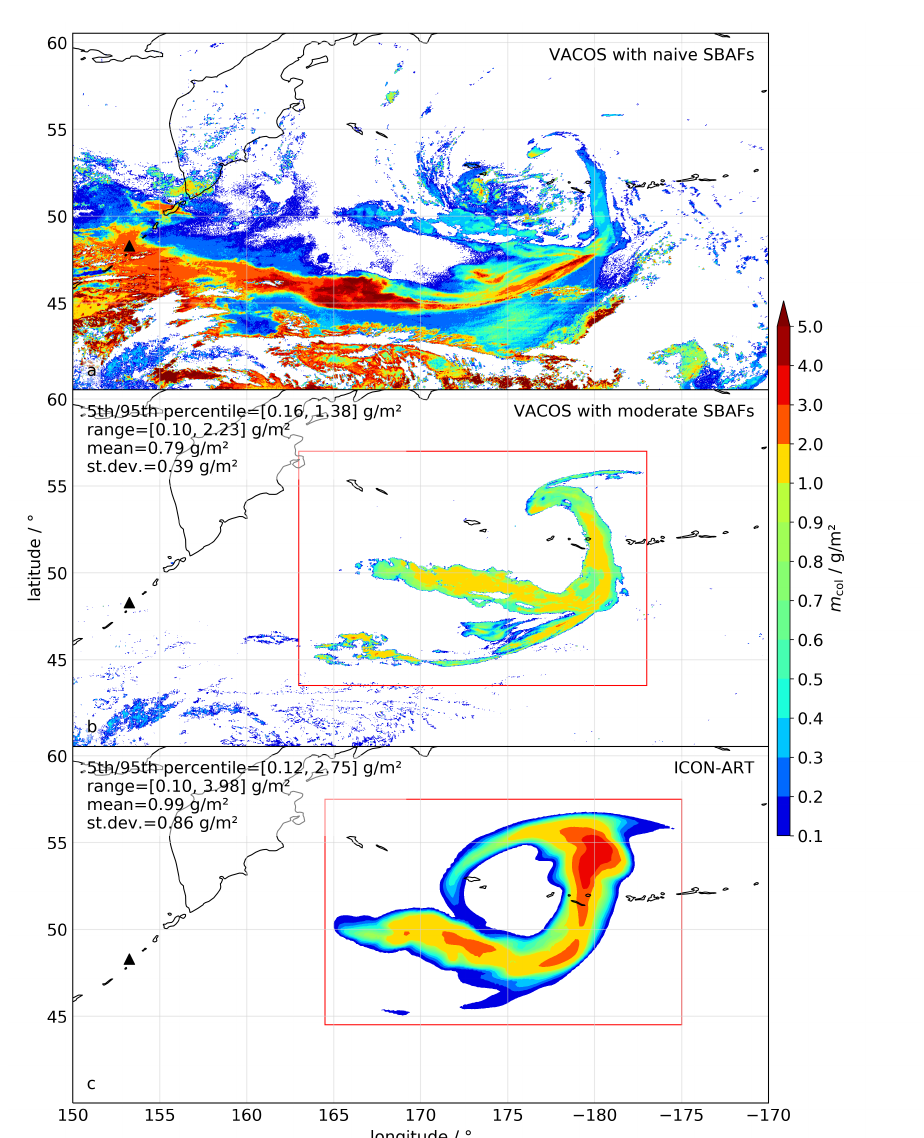
Figure 6. Volcanic ash mass column concentration ( m col ) for the volcanic ash cloud of the Raikoke volcano at 23 June 2019, 02:00 UTC: VACOS retrieval for Himawari-8/AHI data using ( a ) naive SBAFs and ( b ) moderate SBAFs to correct Himawari-8/AHI observations to MSG2/SEVIRI. ( c ) ICON-ART simulation from Muser [72]. Raikoke volcano is indicated by the black triangle in the lower left corner. Different metrics for the distribution of m col are calculated for the area within the red rectangle and given in the upper left